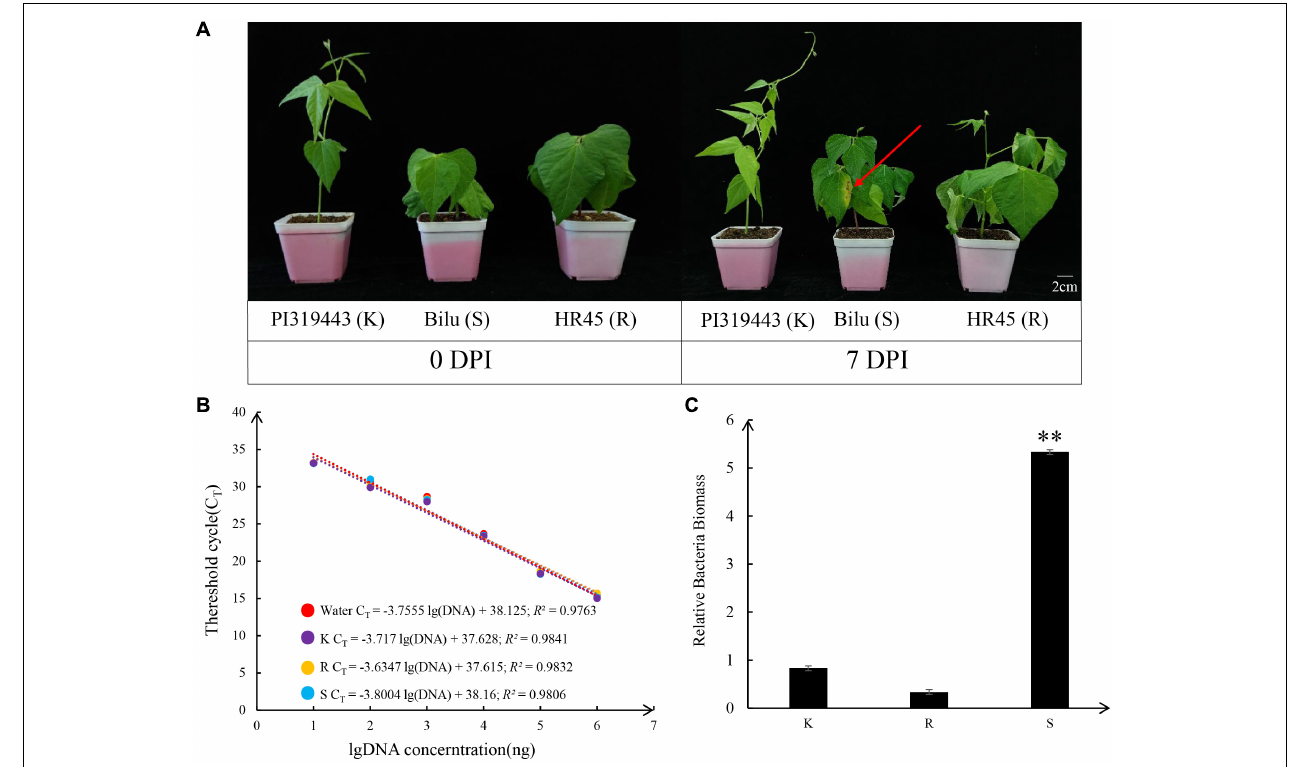
FIGURE 1 | Pathogenicity of strain XS2 on PI 319443, HR45, and Bilu. (A) The picture shows the comparison of three genotypes inoculation pathogen for 7 days, and the red arrows indicate the inoculation area on Bilu. (B) Standard curve based on different concentrations of Xanthomonas axonopodis pv. phaseoli strain XS2 DNA with water and three genotypes DNA solution. (C) Xanthomonas axonopodis pv. phaseoli DNA amount in the inoculated leave of three genotypes detected by real time quantitative PCR. Asterisks indicate significantly different at 0.01 probability levels ( p <